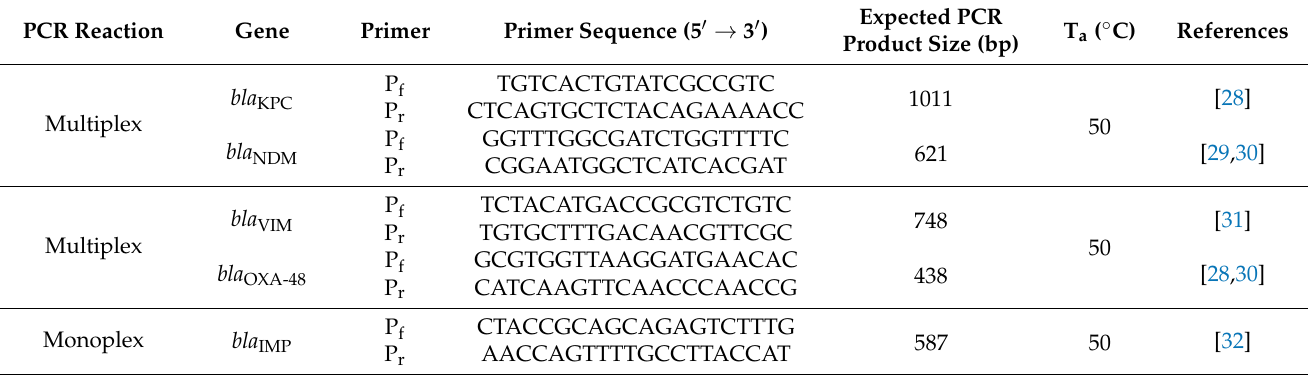
Table 1. Primers used in this study, expected PCR product sizes, and annealing temperatures (Ta). PCR